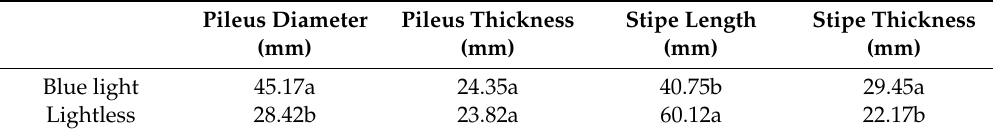
Table 1. Pileus and stipe growth of LE.